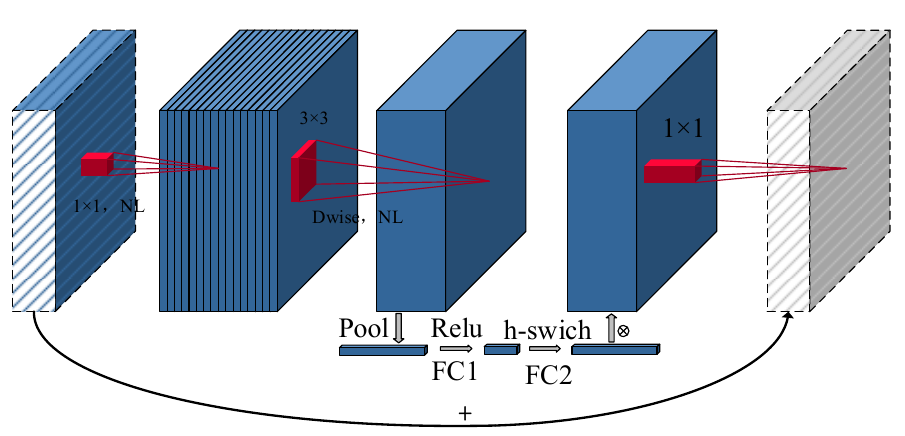
Figure 4. MobileNetV2 + squeeze-and-excite.